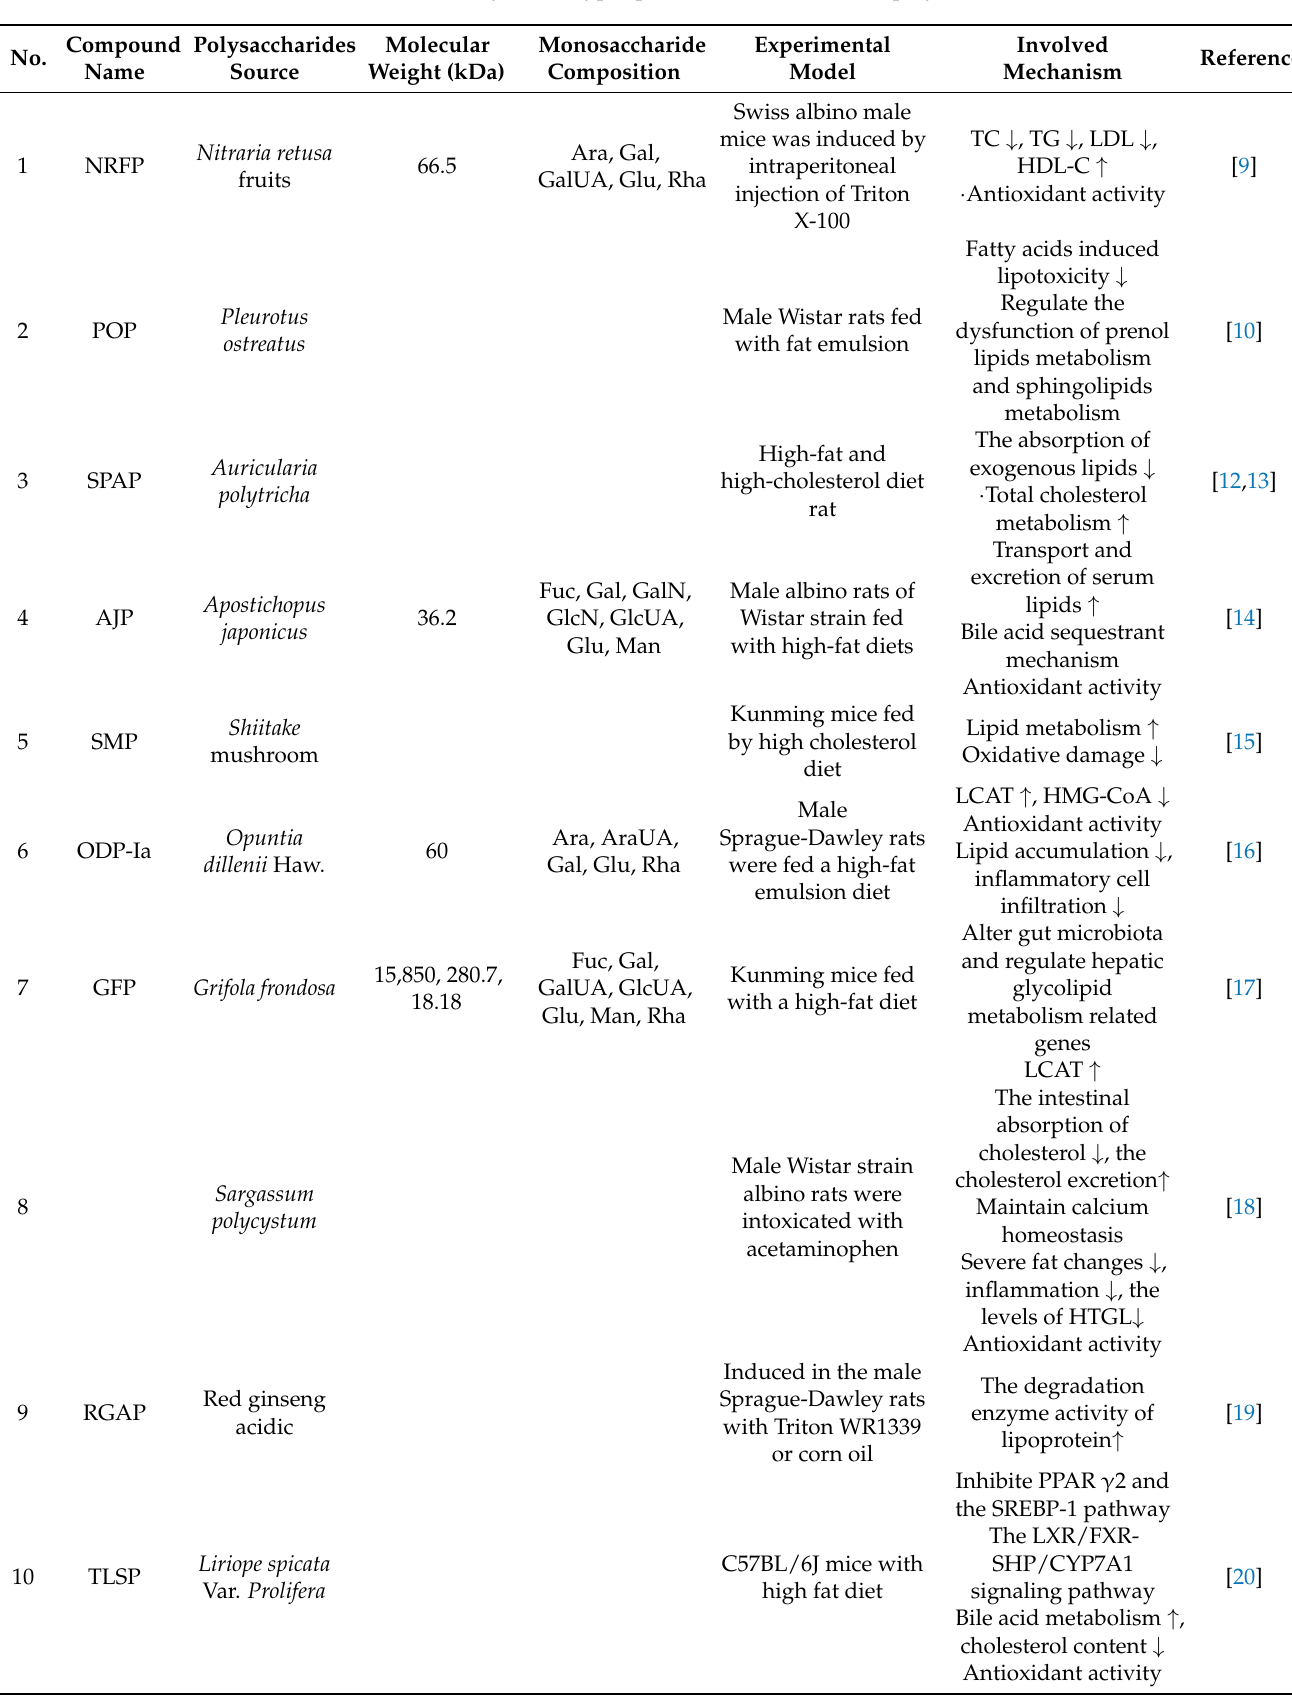
Table 1. Summary of the hypolipidemic effects of natural